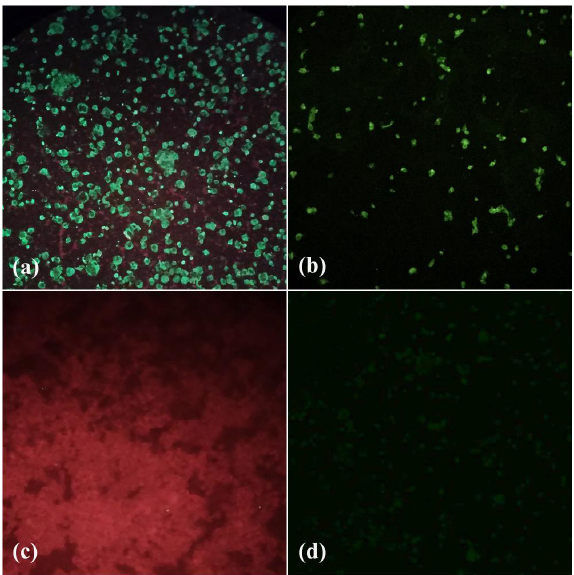
Figure 4. Indirect immunofluorescence reaction (IFI) using polyclonal antibody to Flavivirus. ( a ) C6/36 cells with positive fluorescence reaction. ( b ) Vero cells with a positive fluorescence reaction. ( c ) Negative control C6/36 cells, with cells demarcated using Evans blue staining. ( d ) Negative control Vero cells, showing no fluorescence reaction. Table 2. Distribution of species collected from human attraction and CDC techniques, at Brejeira Farm, Canãa dos Carajás, March 2017. Collection Modalities